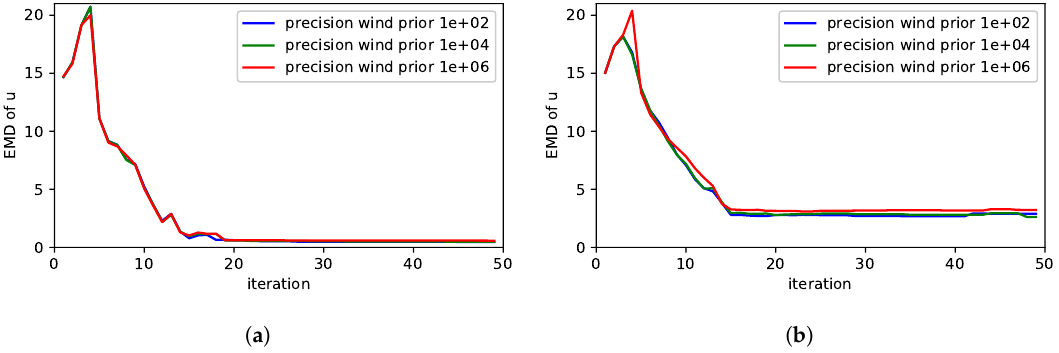
Figure 6. Studies of the precision of the wind prior τ v on the performance of the exploration strategy measured by the EMD of the estimated source distribution: In ( a ) the prior of the wind matches with the simulated wind, in ( b ) the wind direction differs by 30